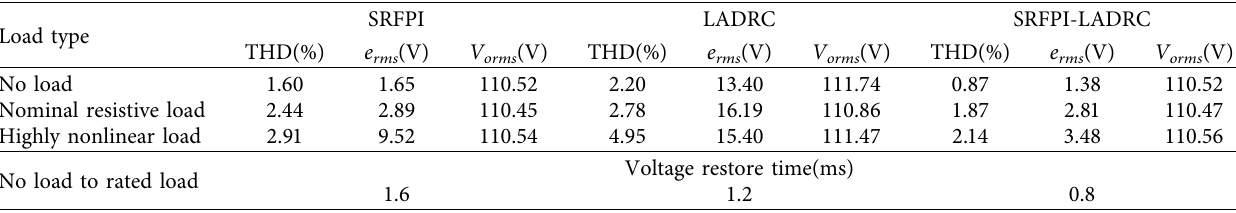
Table 3: Performances of the three methods.